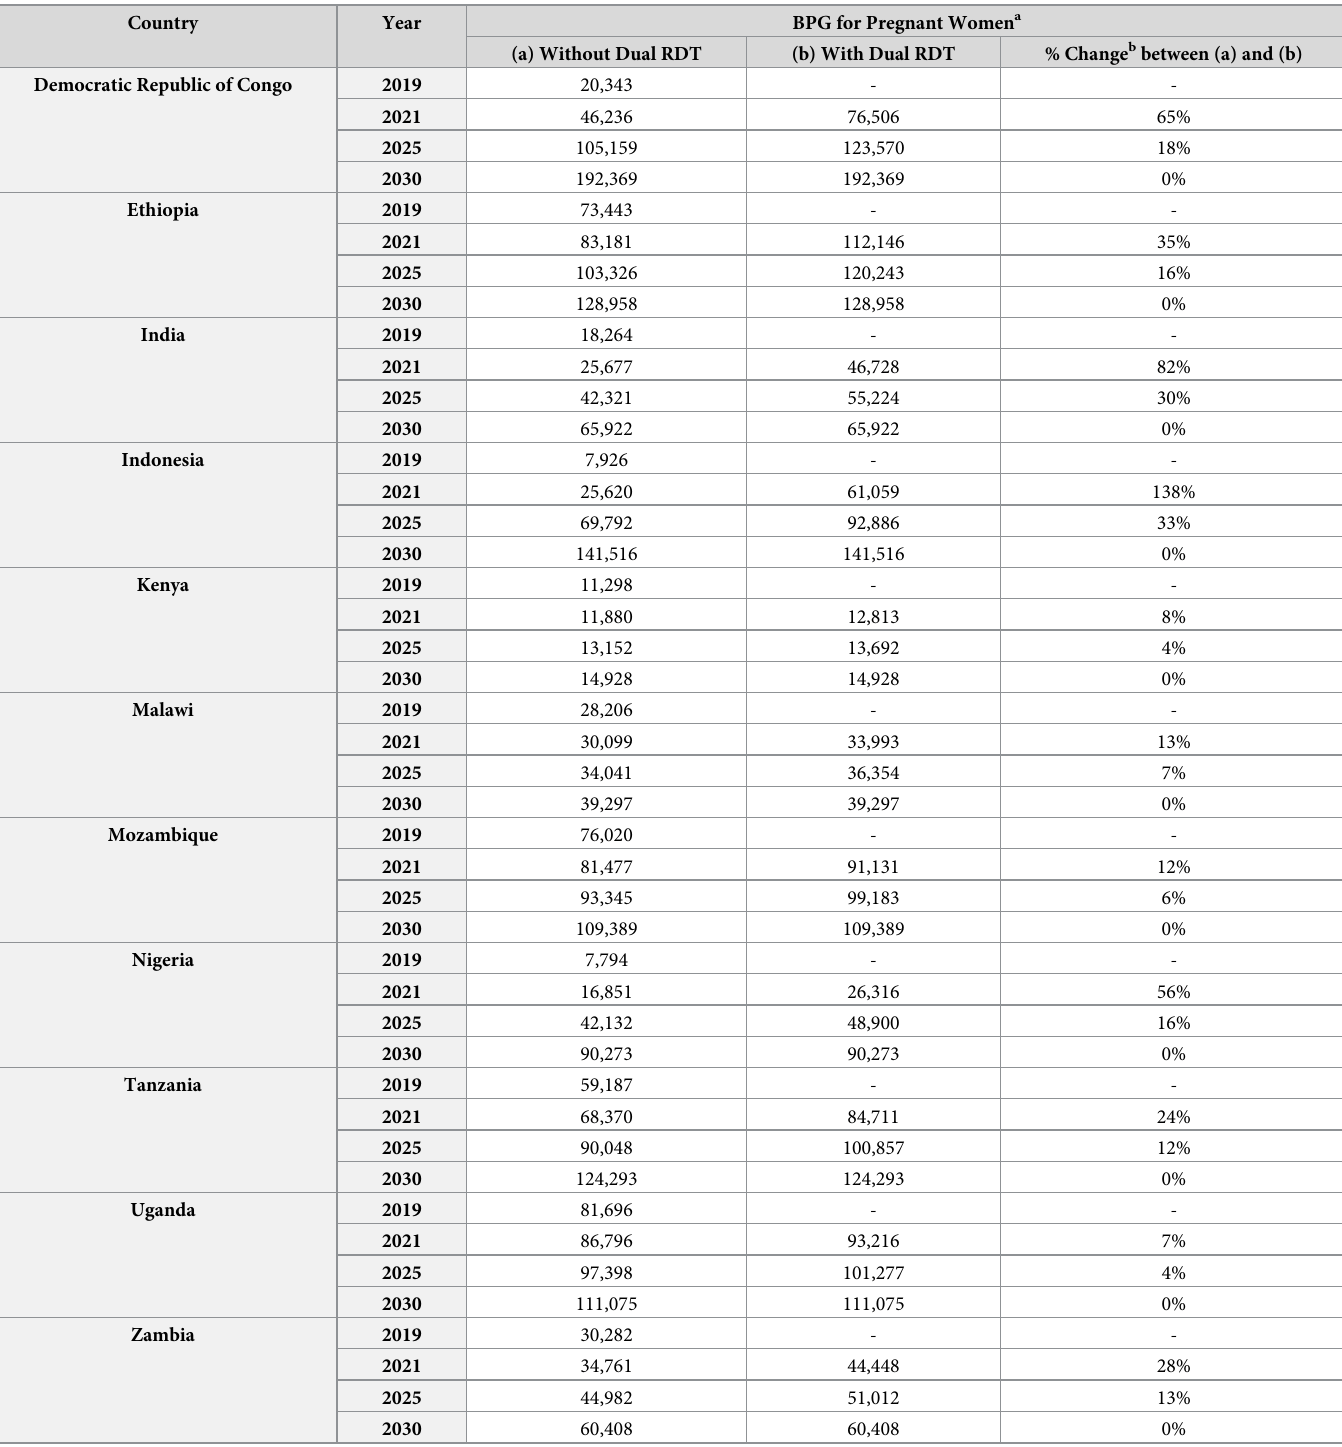
Table 2. Demand for treatment regimen for PW.